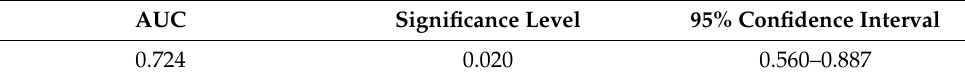
Table 7. The AUC values of the discriminant